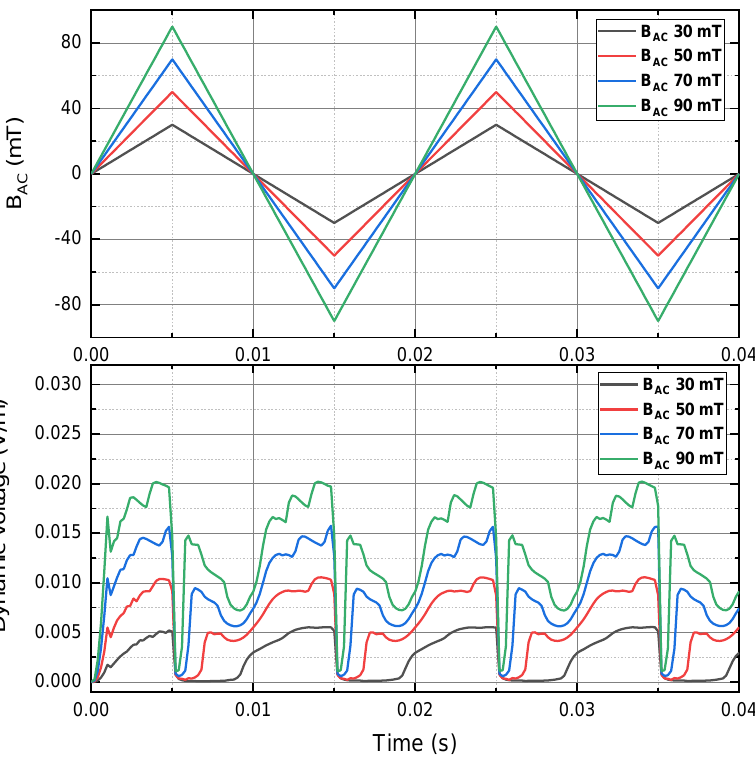
Figure 7. Instantaneous dynamic voltage of a 4 mm HTS tape, carrying a 30 A DC transport current and in the presence of the perpendicular triangle AC magnetic field at 50 Hz, with the peak magnitude 30 mT, 50 mT, 70 mT and 90 mT.